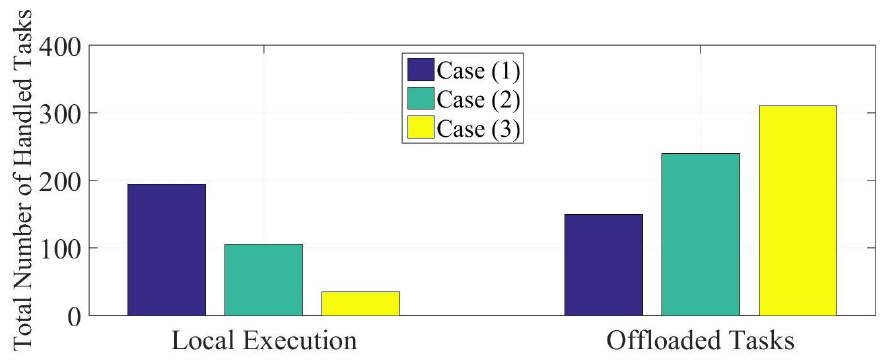
Figure 12. Total number of handled tasks of heterogenous deployed devices and servers for the three considered cases of Figure 13. Total number of local executed tasks and offloaded tasks of the first scenario. the first scenario.